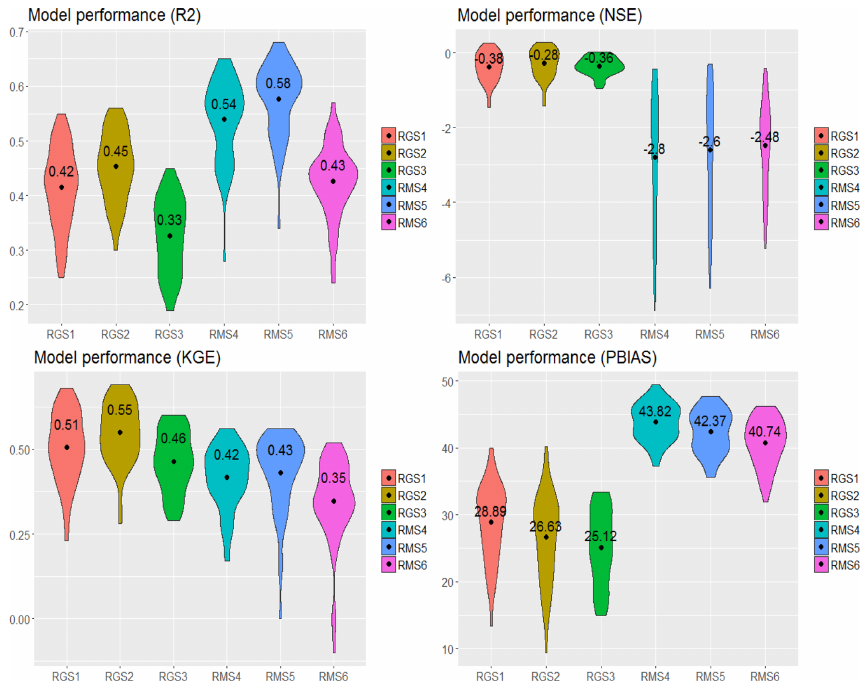
Figure 3. Plots of the performance results for the uncalibrated SWAT in simulating actual evapotranspiration. The values and the black dot symbols ( • ) depict the average value of R 2 , NSE, KGE and PBIAS obtained for each of the reference